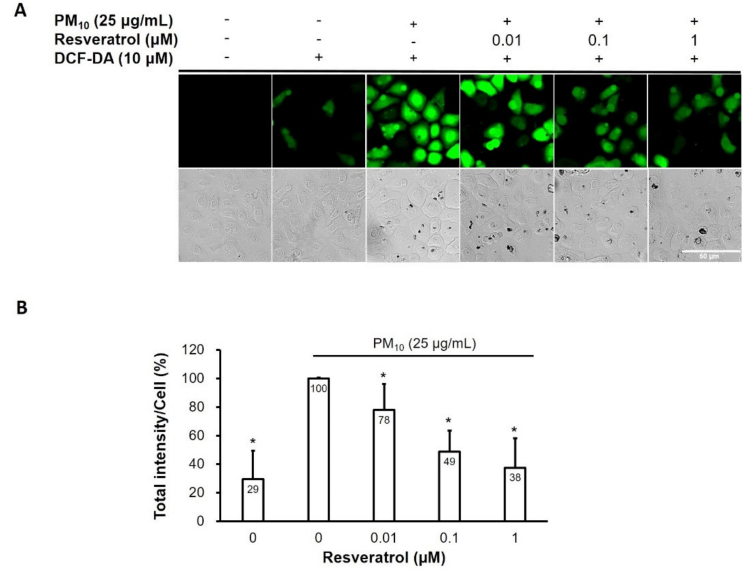
Figure 2. ROS-reducing e ff ect of resveratrol on human keratinocytes following PM treatment. ( A ) Confocal microscopic images of the DCF-DA assay (ROS; green) ( B ) Relative intracellular ROS fluorescence intensity. Data are presented as the mean ± standard deviation of three independent experiments ( n = 3). * p < 0.05 vs. PM-treated, resveratrol-untreated samples. ROS, reactive oxygen species, PM, particulate matter, DCF-DA, 2 (cid:48) ,7 (cid:48) -dichlorodihydrofluorescein